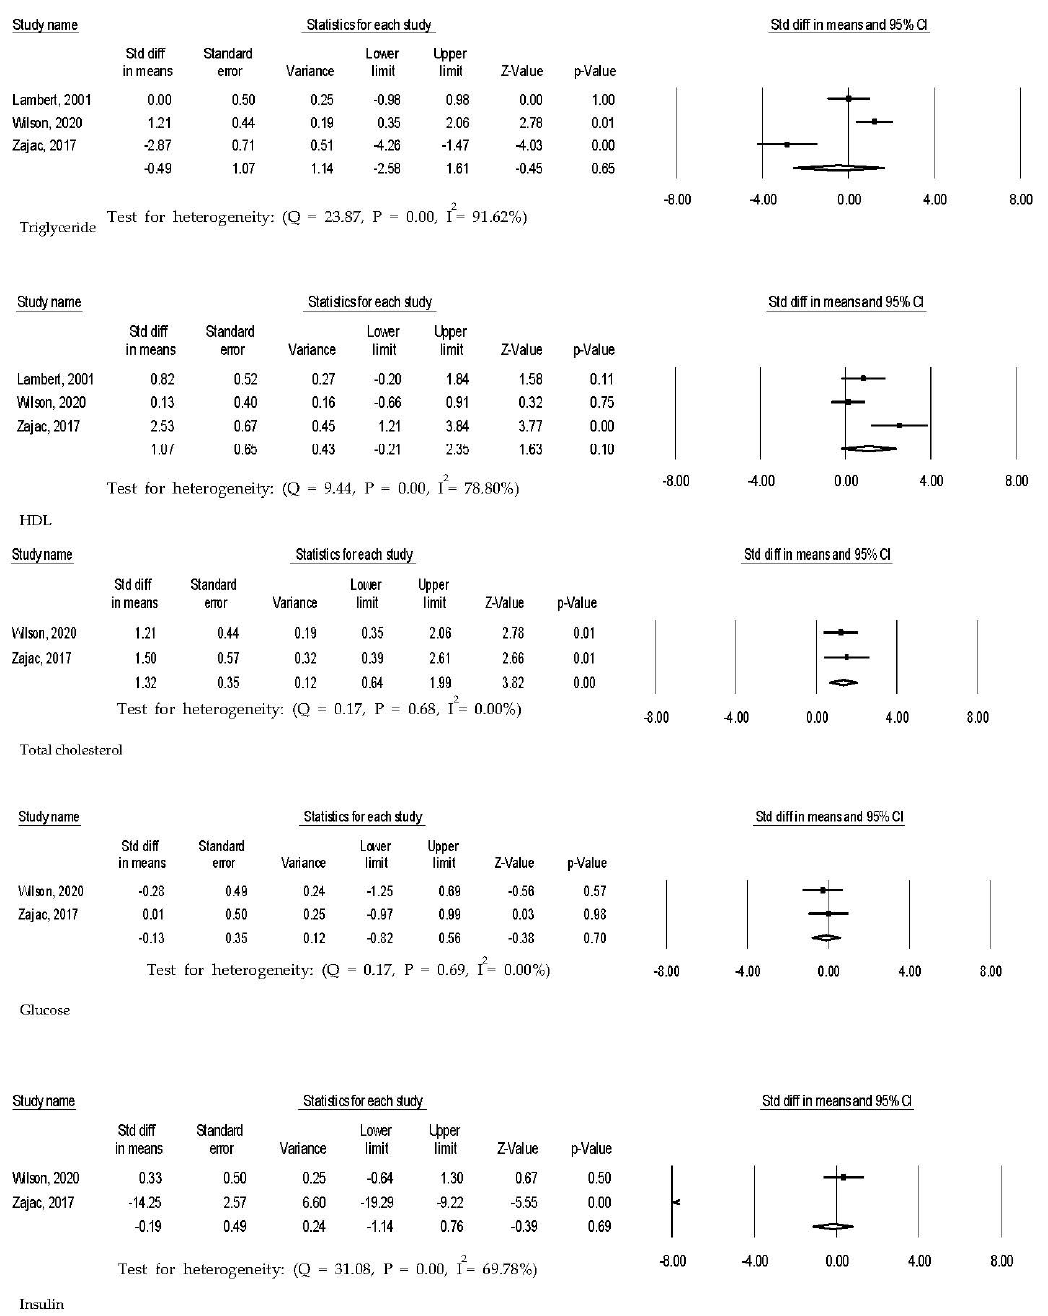
Figure 2. Effect sizes of ketogenic diet interventions for athletes.